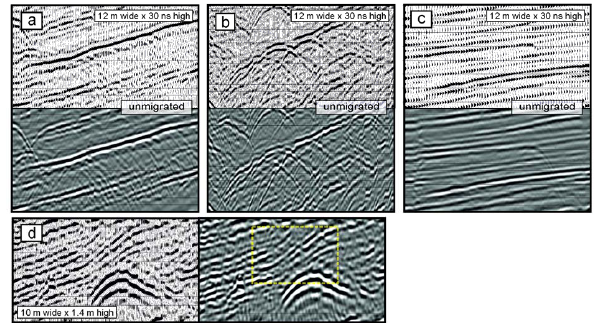
Figure 9: Details from characteristic internal structures displayed in wiggle trace and variable density modus. (a) The detail of Fig. 4 shows many point sources at regular interval superimposed on the banded layers. (b) Much fewer point sources occur at irregular intervals on the detail from Fig. 7. (c) The layers appear without point reflectors, but the termination of a layer is indicated by a pronounced diffraction hyperbola (see Fig. 6). (d) The curved structure imaged in Fig. 4 probable originates from an underlain boulder.